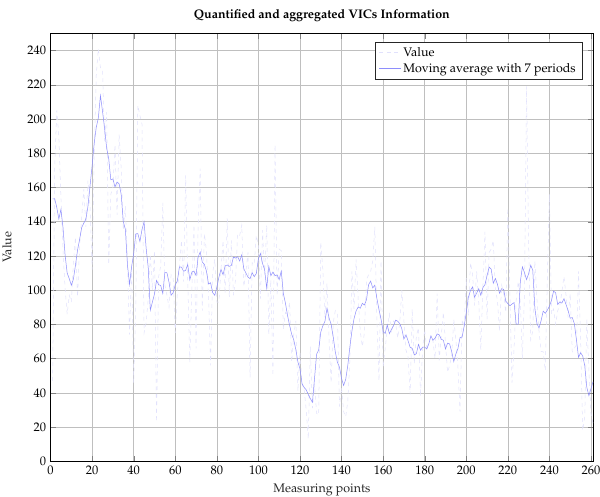
Figure 3. Aggregated Sentiment based on VICs Recommendations of Trading Year